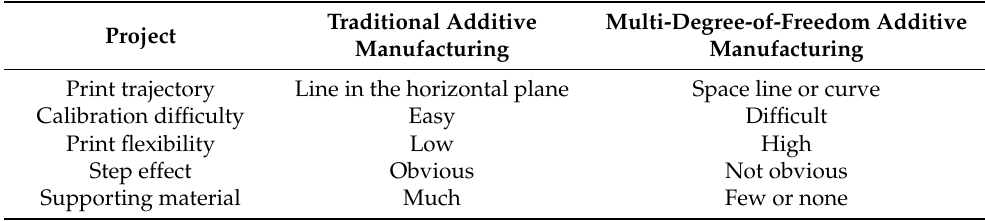
Table 2. Comparison of between traditional additive manufacturing and multi-degree-of-freedom additive manufacturing. Traditional Additive Multi-Degree-of-Freedom Additive Project Manufacturing Manufacturing Print trajectory Line in the horizontal plane Space line or curve Calibration difficulty Easy Difficult Print flexibility Low High Step effect Obvious Not obvious Supporting material Much Few or